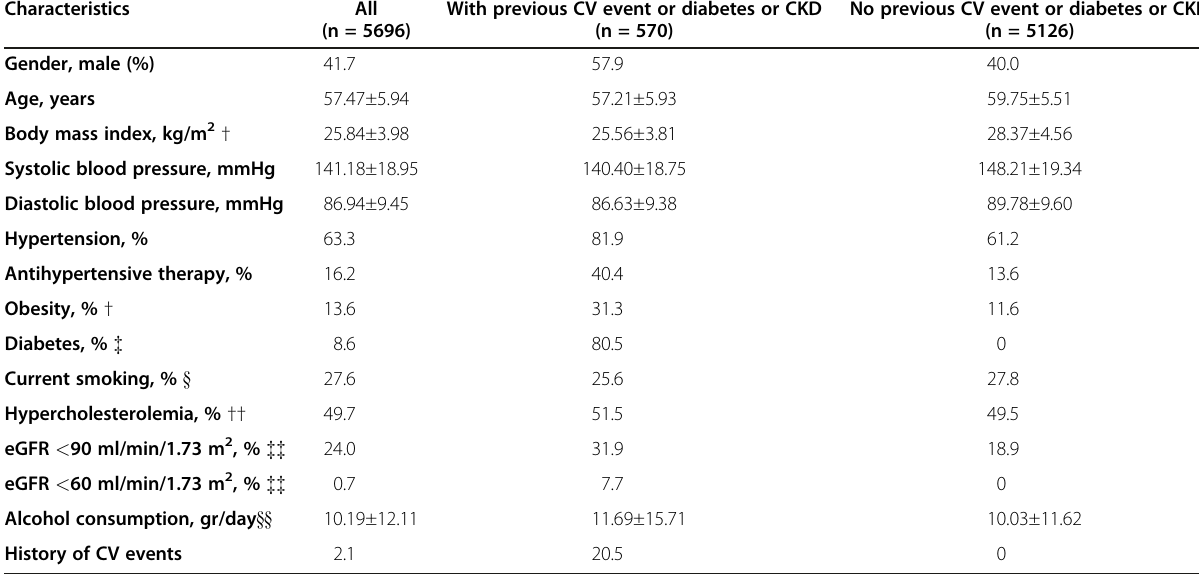
Table 1 Anthropometric and metabolic features of the whole sample and divided by people with either previous cardiovascular event, diabetes mellitus and chronic kidney disease (CKD)